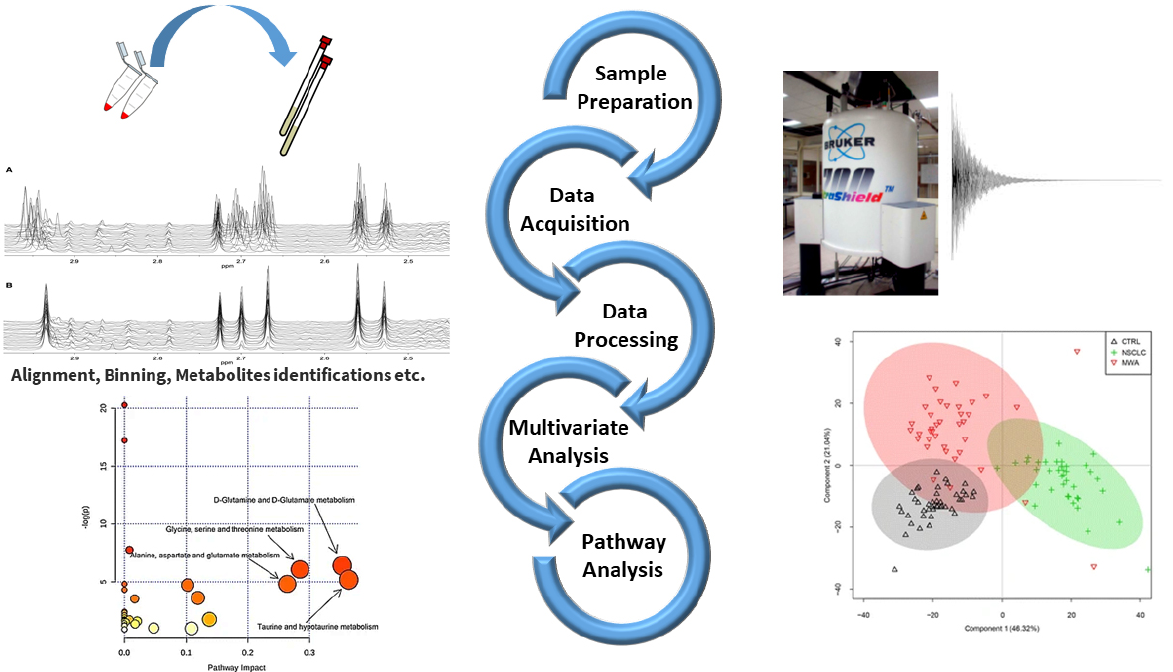
Figure 1. Schematic workflow illustrating the steps of NMR based metabolomic studies coupled with chemometrics and pathway analysis. (1) Sample preparation and NMR tube filling (top left); (2) experimental parameters setting and data acquisition (top right); (3) data processing (middle left); (4) execution of multivariate statistical analysis (bottom right); (5) determination of metabolic path- ways (bottom left). Some figures are reprinted from Refs. [22,23] under the terms of the CC-BY